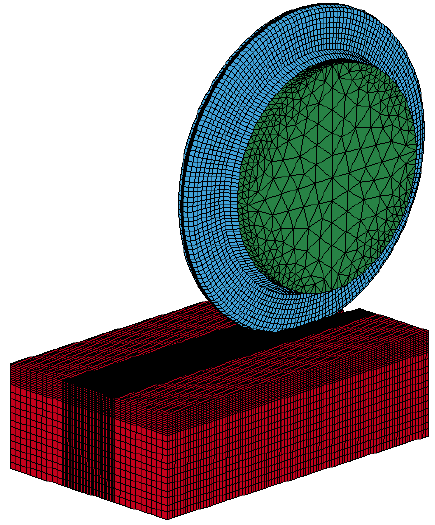
Figure 6. Model of rock breaking by disc cutter.